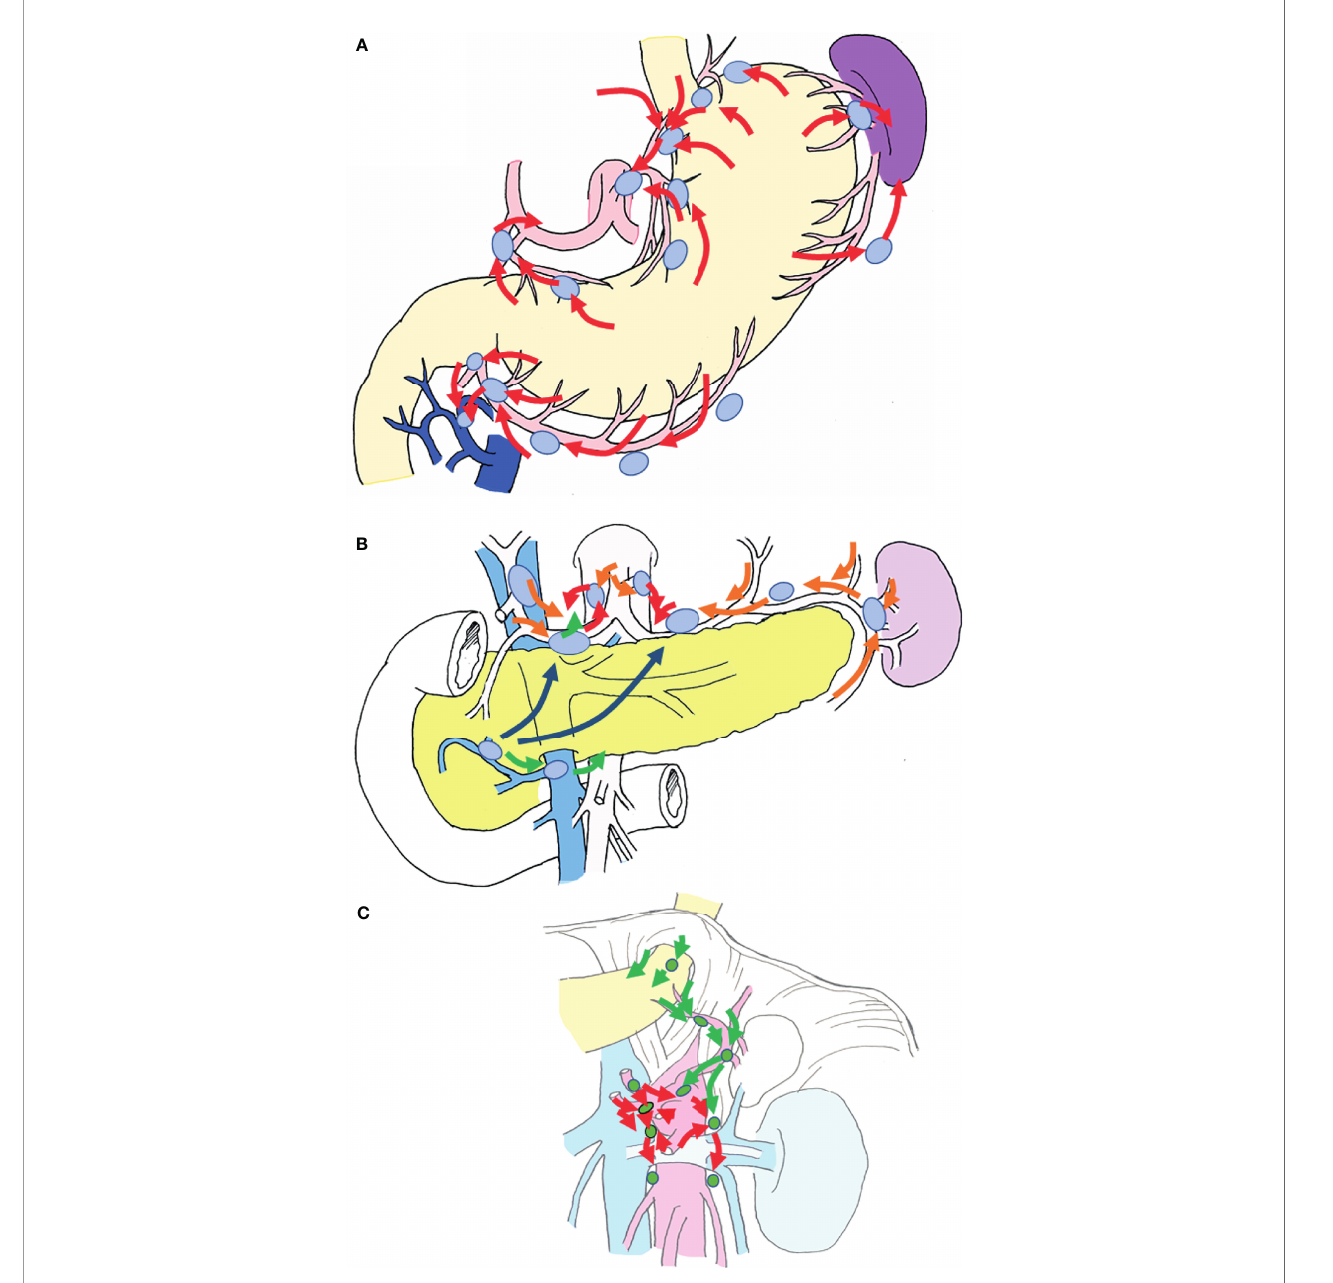
FIGURE 2 | Schematic diagram of the lymphatic system of the stomach. The lymphatic fl ow of the stomach spreads from the perigastric nodes, via the suprapancreatic nodes and nodes around the celiac artery, to the para-aortic nodes, following which it enters the systemic circulation. (A) Lymphatic fl ow from the gastric wall is directed to the root of each artery via nearby perigastric nodes (red arrows). (B) The lymphatic fl ow into the root of each artery fl ows via suprapancreatic nodes (orange arrows) and out to the paraaortic nodes from the left and right of the celiac artery (red arrows). There are also routes from #8a to #8p (the posterior side of the common hepatic artery), and routes from #6 to the root of the superior mesenteric artery via #14v (green arrows). Routes from #6 to the suprapancreatic nodes via the lymphatics under the pancreatic capsule are also available (indigo arrows). (C) Lymphatic fl ow around the celiac artery and the superior mesenteric artery lead to the paraaortic nodes, which are the terminal lymph nodes of gastric cancer (red arrows). A route from the left dorsal side of the cardia to #16a2 lateral nodes via #19, along the left subphrenic artery also exists (green